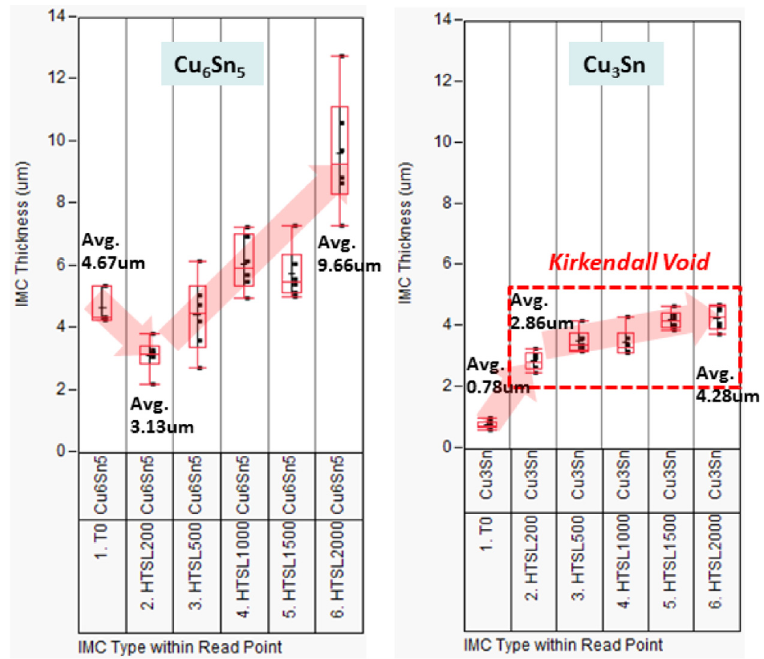
Figure 13. Cu 6 Sn 5 and Cu 3 Sn IMC thickness under HTSL stress